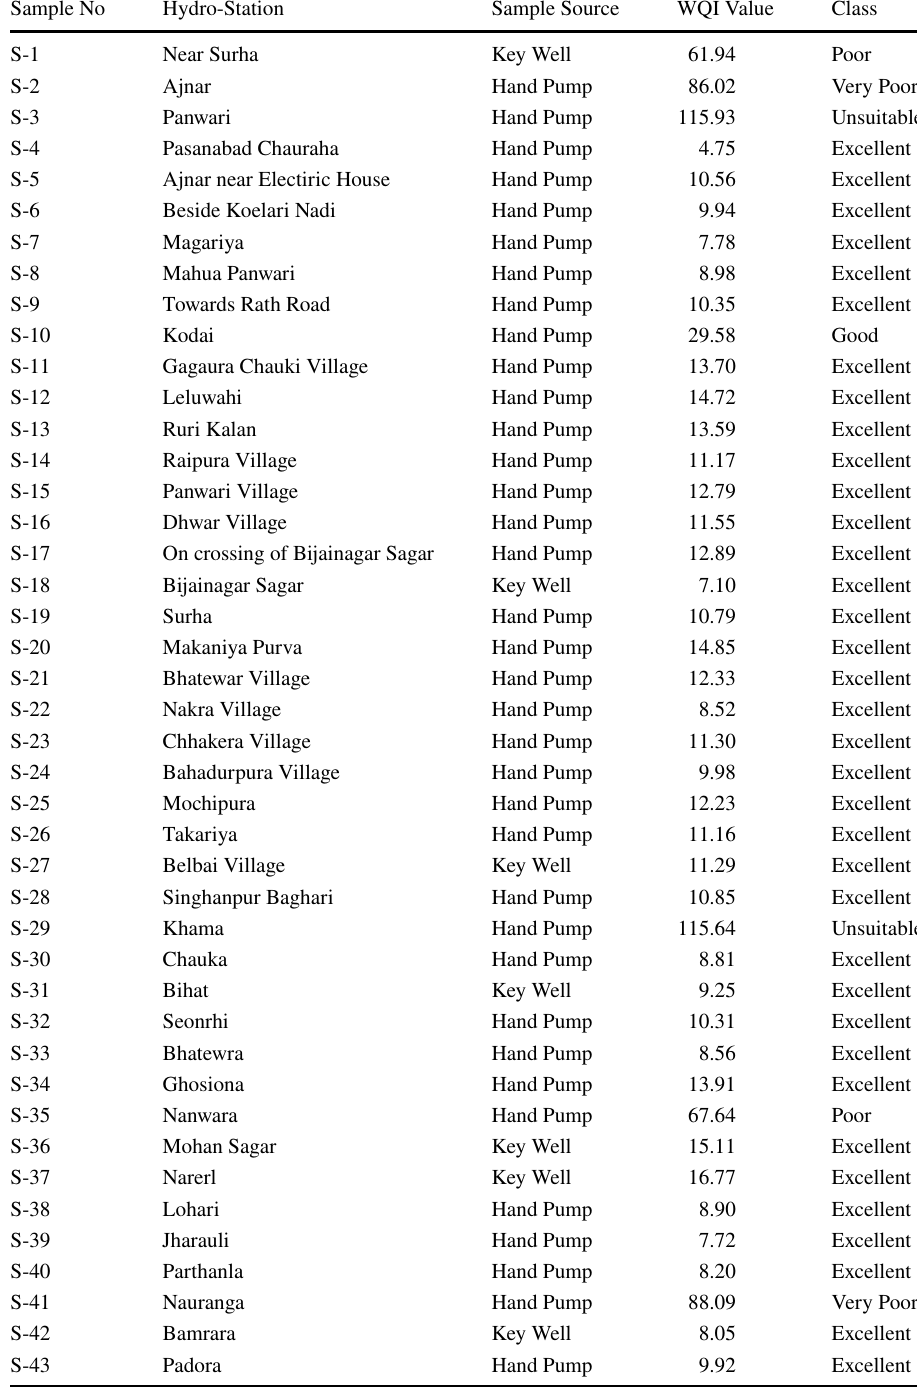
Table 5 Water quality index and its quality class for each hydro- station in study